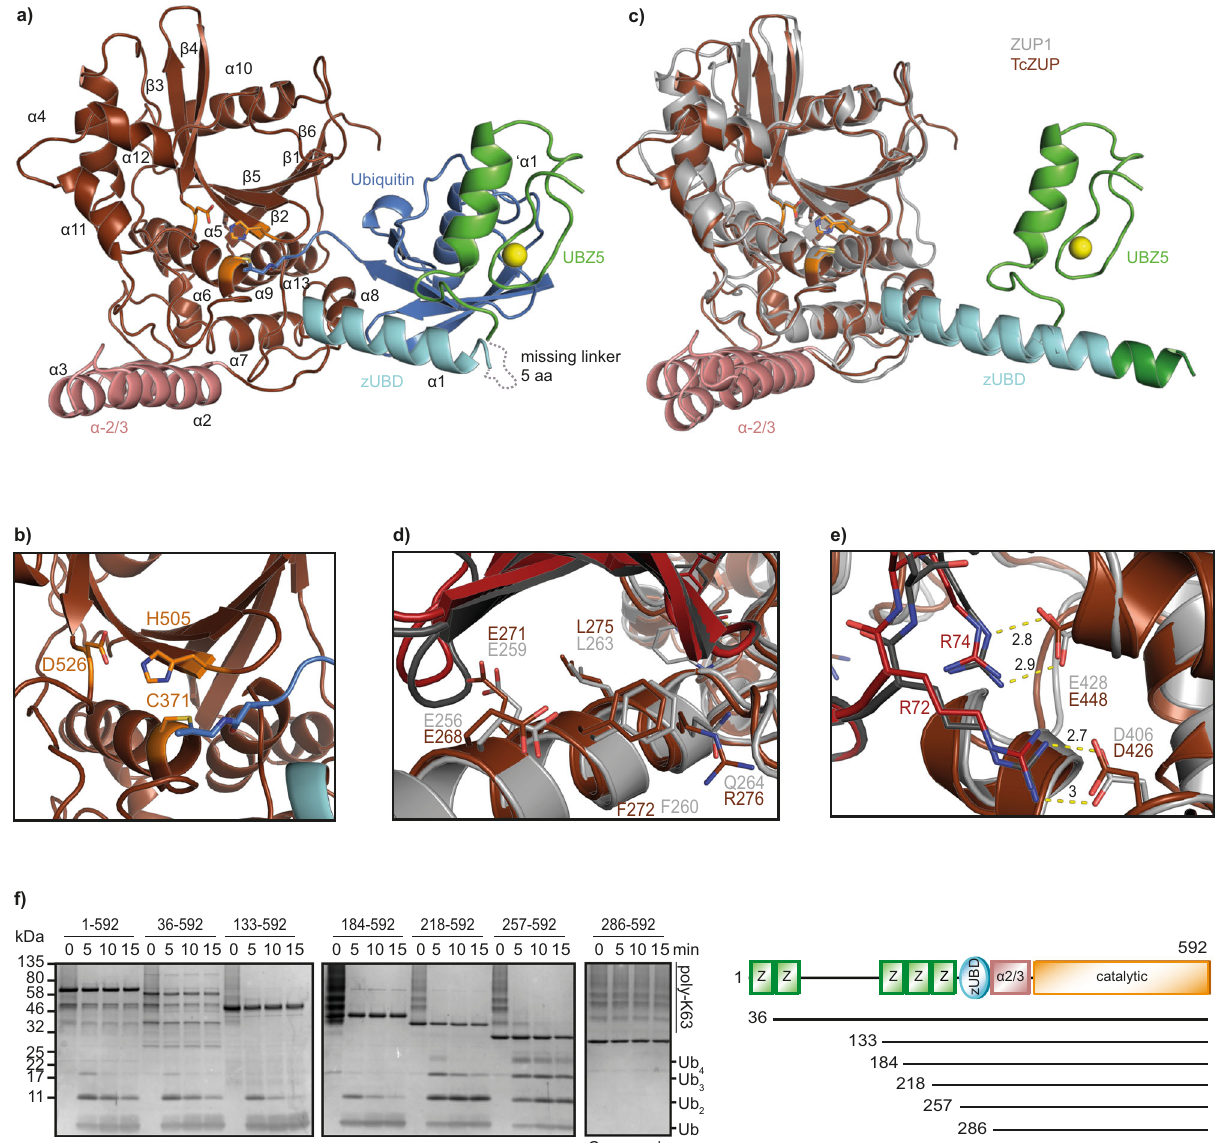
Fig. 3 Crystal structure of T. castaneum ZUP bound to a covalent Ub probe. a Overview of the crystal structure in cartoon representation. The catalytic core of TcZUP is shown in brown, ubiquitin in blue. The ZnF is colored green, the zUBD region in cyan and the α -2/3 region in red. The catalytic triad is shown as orange sticks. The Zn atom of the ZnF is shown as a yellow sphere. b Magni fi cation of the active site of TcZUP (brown). The catalytic triad is shown as sticks and colored orange. c Structural superposition of TcZUP (brown) and ZUP1 (6EI1, gray). RMS distance is 1.3 Å over 304 residues. The characteristic helical protrusions of ZUP1 and TcZUP are colored cyan (zUBD) and red ( α -2/3). The ZnF of TcZUP and the MIU of ZUP1 are colored light and dark green respectively. d Ubiquitin binding by the zUBD is conserved in TcZUP. The zUBD of ZUP1 (light gray) and TcZUP (brown) were superimposed and shown in cartoon representation. Key residues are highlighted as sticks. The corresponding ubiquitins are shown in carton representation and colored dark gray and red, respectively. e Recognition of ubiquitin C terminus by the catalytic core of TcZUP. The TcZUP/ubiquitin (brown/red) and the ZUP1/ubiquitin (light gray/dark gray) complexes are superimposed and shown in cartoon representation. Key residues are highlighted as sticks. Salt bridges are indicated by dotted lines. f Activity of TcZUP FL and truncations lacking the UBDs against K63-linked Ub 6 + chains. A mixture of K63-linked poly-ubiquitin chains (Ub 6 + ) are cleaved over time to mono-, di-, tri-, and tetra-ubiquitin. The reaction was stopped after the indicated time points, separated by SDS-PAGE and coomassie stained. Source data are provided as a Source Data fi TcZUP. As shown in Fig. 3d, the contact residues of ZUP1 (Glu- architecture with multiple UBZ-like zinc fi ngers, which in ZUP1 256, Glu-259, Phe-260, Leu-263, and Gln-264) are structurally are dispensable for catalysis and have a modest in fl uence on the equivalent to the TcZUP contact residues Glu-268, Glu-271, Phe- cleavage rate for long ubiquitin chains. To assess the importance 272, Leu-275, and Arg-276. The same is true for the recognition of the different TcZUP UBDs, a series of truncations were tested of the ubiquitin C terminus: Arg-72 and Arg-74 of ubiquitin form for their activity on K63-linked Ub 6 + chains. As shown in Fig. 3f, TcZUP truncations lacking the fi rst one, two, or three zinc fi ngers salt bridges with Asp-406 and Glu-428 of human ZUP1, and their (TcZUP 36 – 592 , TcZUP 133 – 592 and TcZUP 184 – 592 ) cleave Ub 6 + corresponding residues Asp-426 and Glu-448 in TcZUP (Fig. 3e). chains with similar kinetics as the full-length form TcZUP1 – 592. The N-termini of human ZUP1 and insect TcZUP have a similar